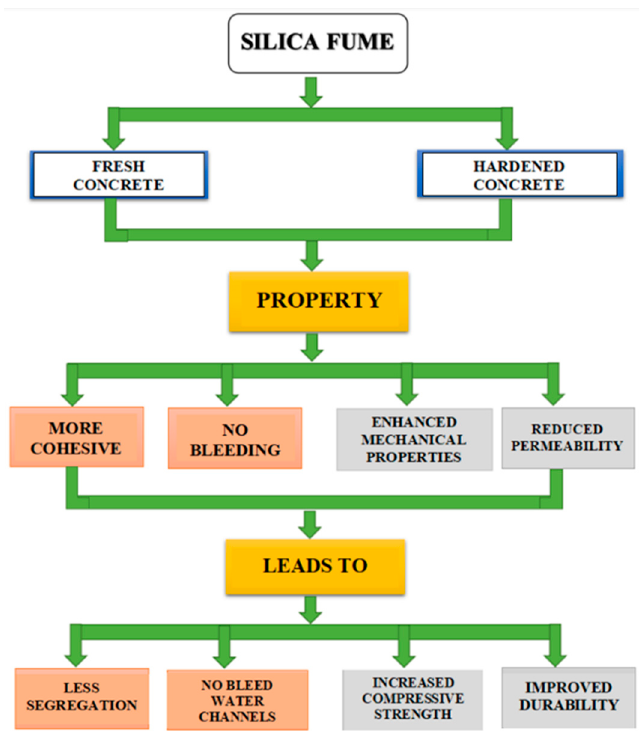
Figure 5. Schematic of mechanistic action of SF in fresh and hardened concrete .